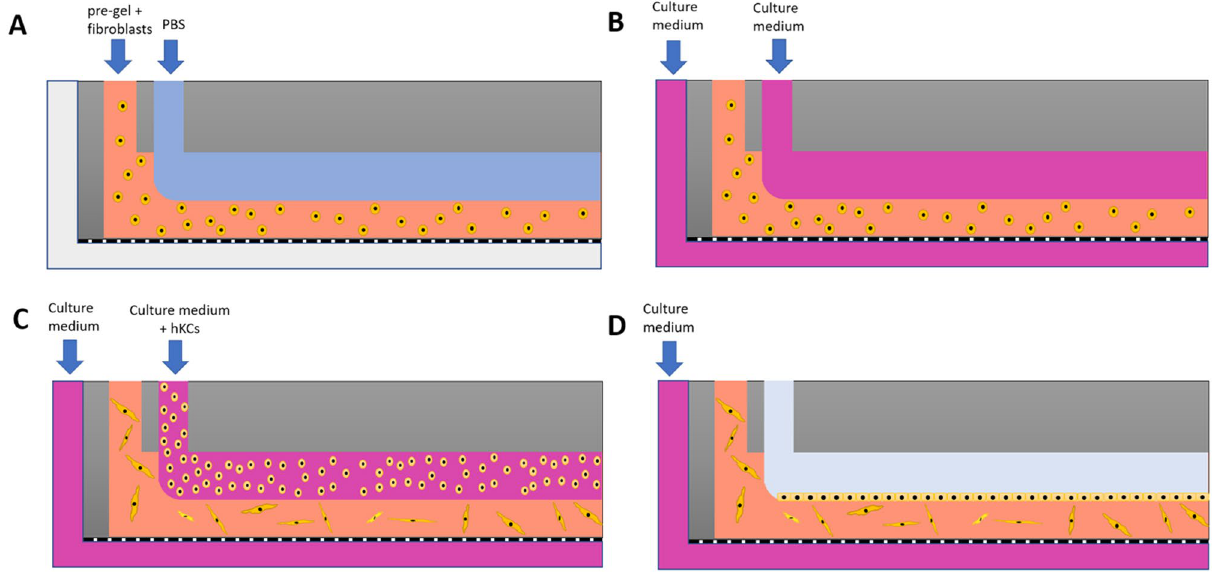
Figure 5. Steps followed to generate a bilayer tissue model inside the microfluidic device. ( A ) Parallel flow of PBS and pre-gel with hFBs. ( B ) Supplemented culture medium is pumped for 24 h to nurture the hFBs. ( C ) DMEM containing hKCs is pumped on top of the dermal compartment and kept resting for 6 h to allow cell attachment to the fibrin hydrogel surface. ( D ) As a final step, DMEM should be removed from the UC by pumping air to leave the hKCs exposed to the air–liquid interface to induce their differentiation and stratification. Grey colour represents air in the